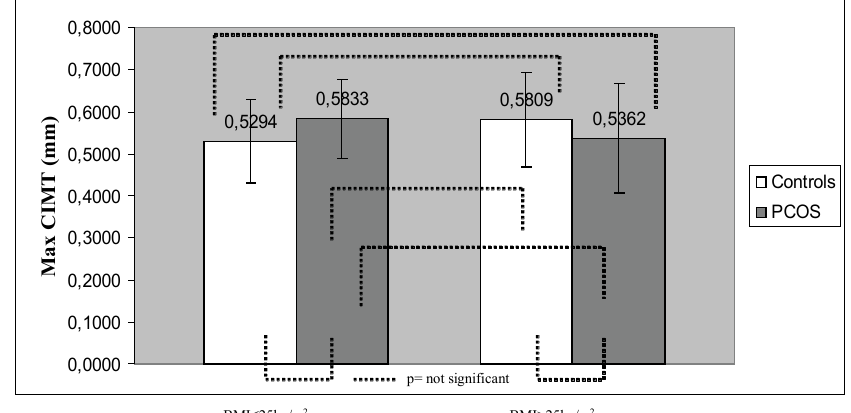
Data are given means ± SE, p<0. 05 statistically